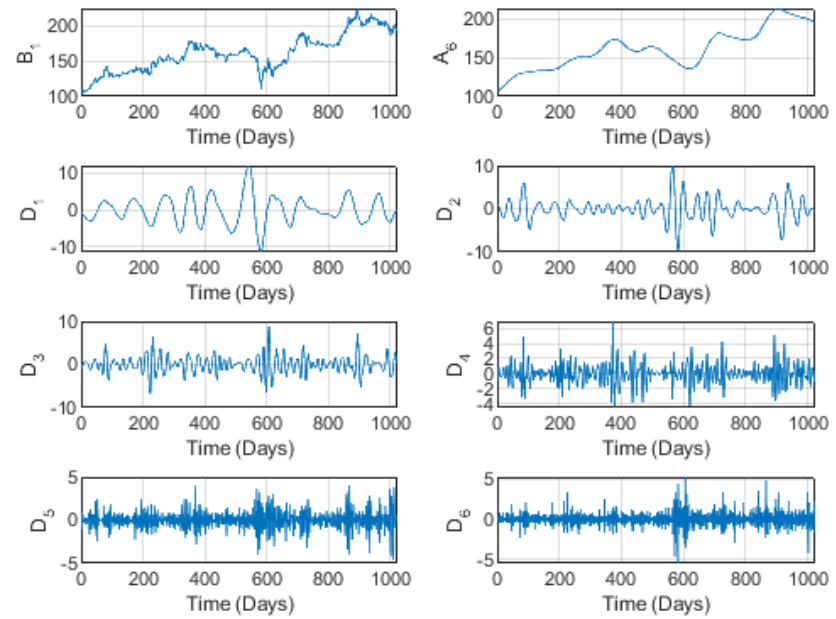
Figure 1. The wavelet decomposition of the Jarir brand B 1 prices at level 6.